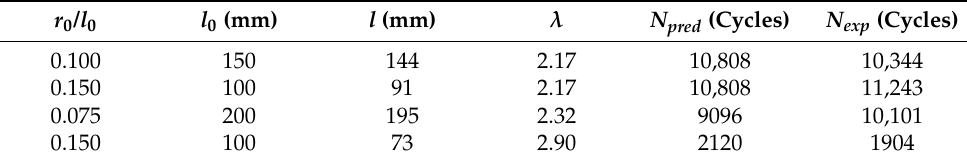
Table 3. Comparison between the predicted ( N pred ) and the experimental ( N exp ) life